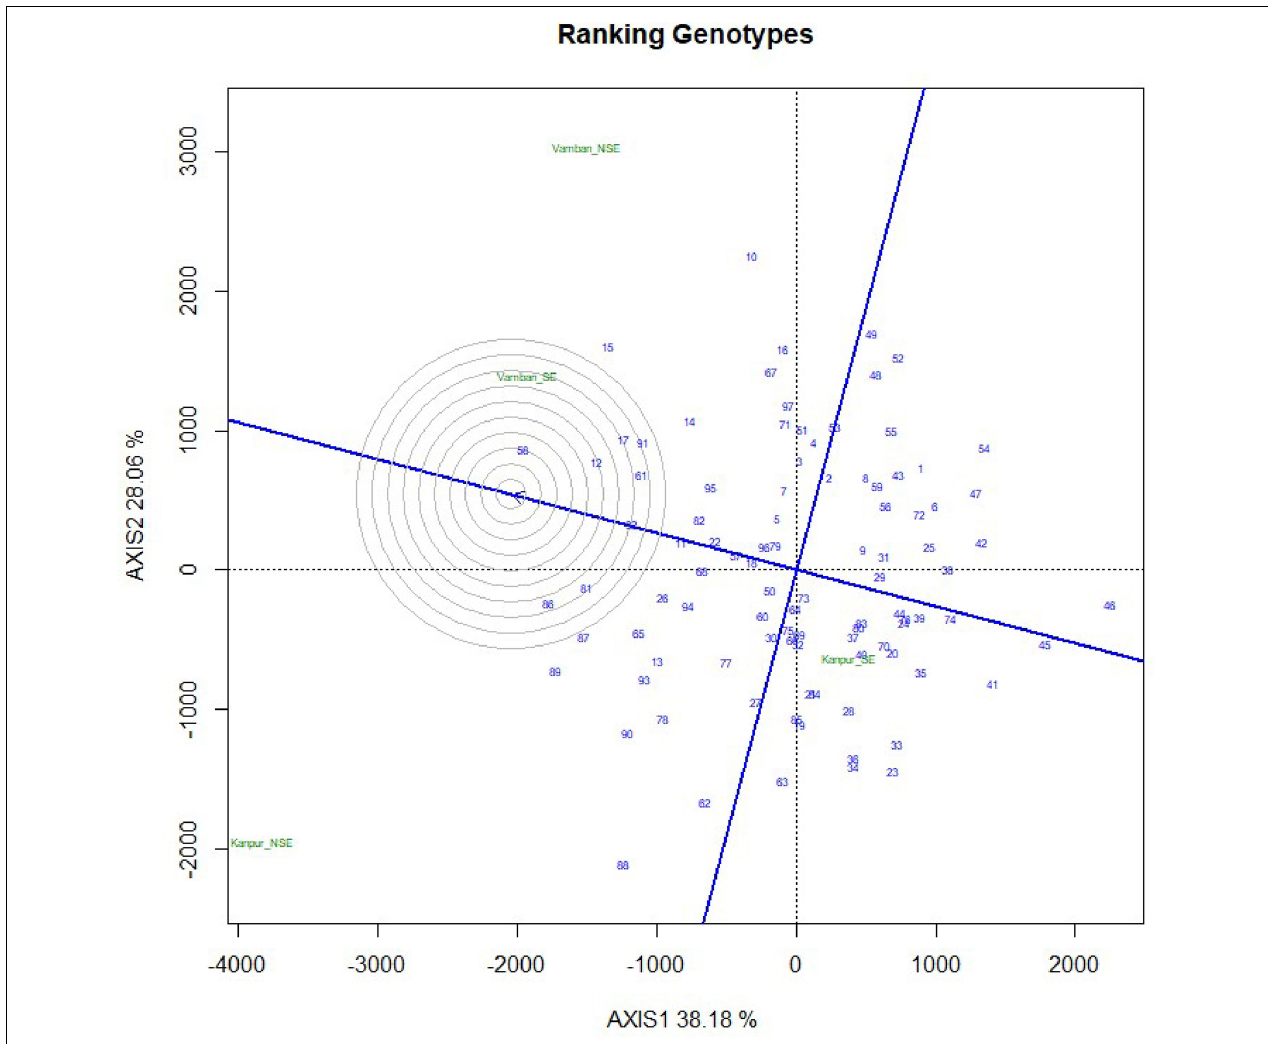
FIGURE 2 | Ranking of 97 urdbean geneotypes by GGEBiplot analysis on the basis of yield data across four growing